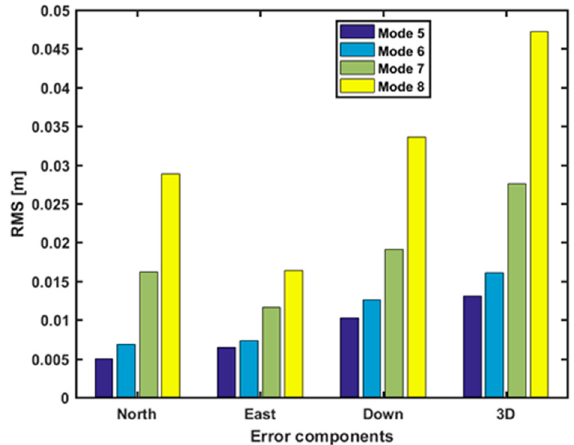
Figure 20. Comparison of relative position error of modes 5–8 in test 2.